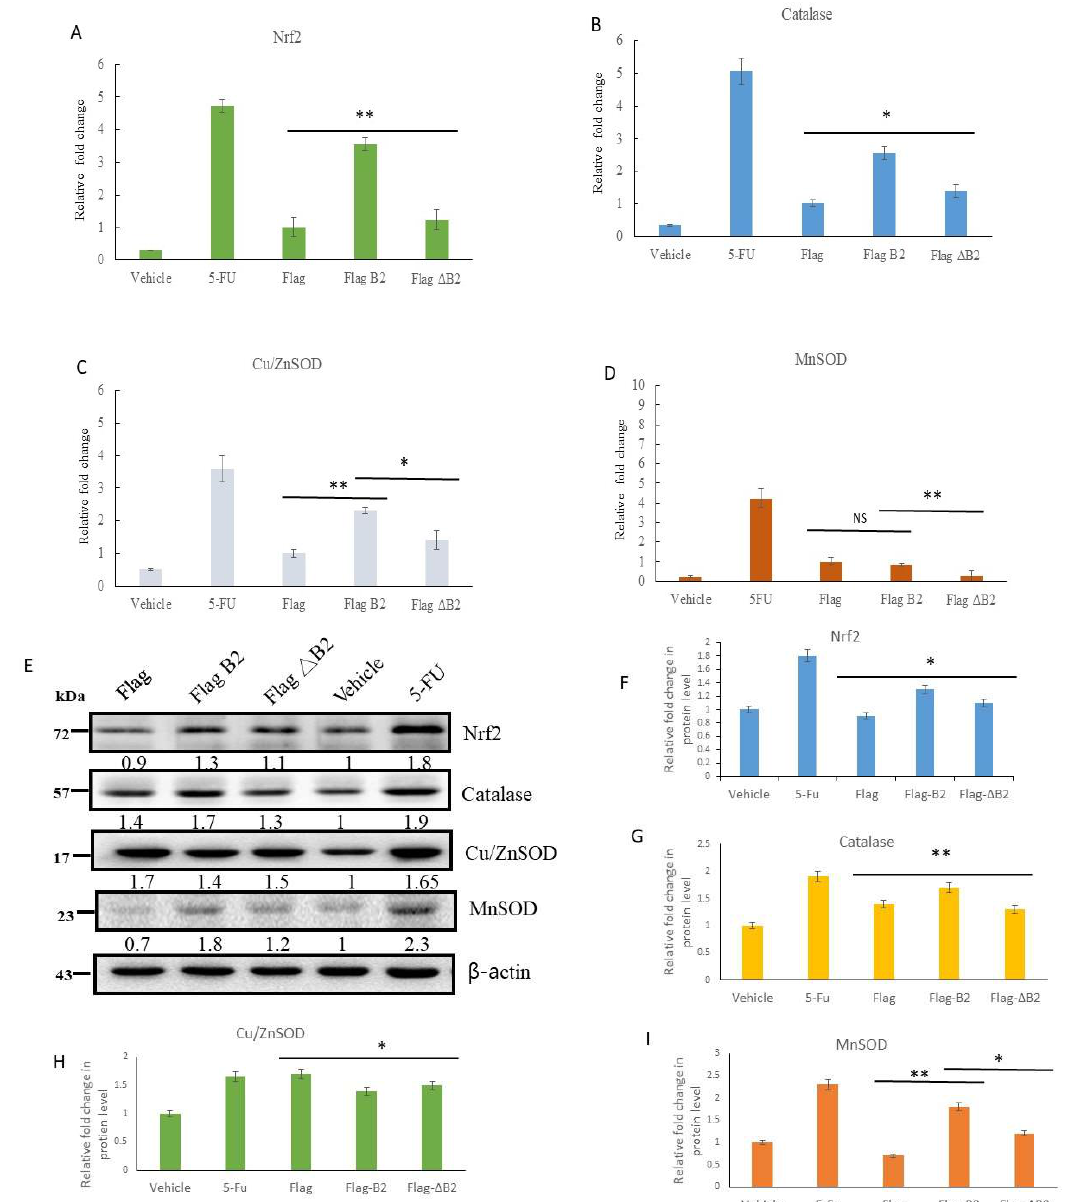
Figure 5. B2 protein induces ROS/Nrf2-mediated redox oxidative stress signals via stress markers catalase, Cu/ZnSOD, and MnSOD in NOD/SCID mice. RT-qPCR analysis of oxidative stress signal via stress markers ( A ) Nrf2, ( B ) catalase, ( C ) Cu/ZnSOD, and ( D ) MnSOD, suggesting the induction of a ROS/Nrf2-mediated redox oxidative stress signal in solid tumors ( N = 4–6). The data are representative of three separate experiments, and the error bars represent the SEMs. * p < 0.05 and ** p < 0.01, as analyzed by one-way ANOVA with Tukey’s multiple comparisons. ( E ) Upregulation of B2-mitochondria-targeting-induced catalase, MnSOD, and Cu/ZnSOD expression in A549 cell solid tumors according to Western blot analysis. ( F – I ) Quantification of the results in E. The data are representative of three separate experiments, and the bars represent the SEMs. * p < 0.05 and ** p < 0.01, NS = not significant, as analyzed by one-way ANOVA with Tukey’s multiple